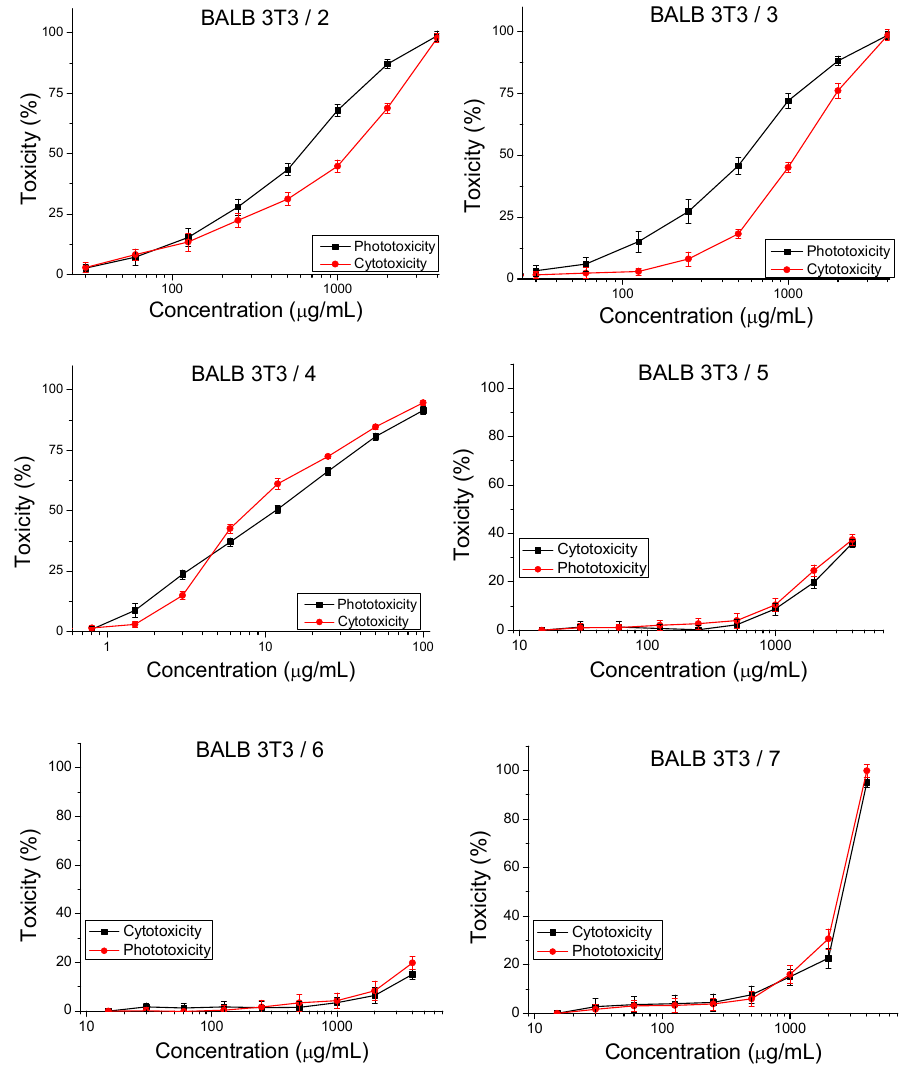
Figure 5. Cytotoxicity and phototoxicity of compound 2 – 7 to BALB 3T3 expressed in % relative to the negative control.